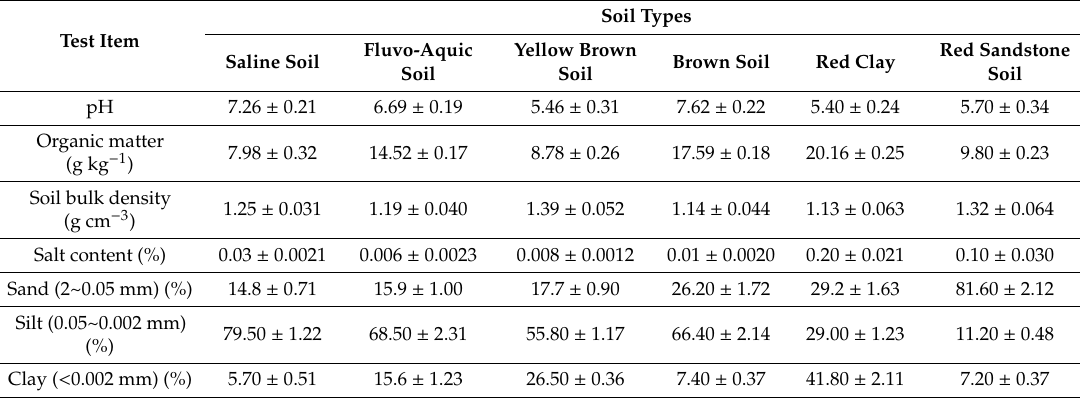
Figure 2. Geographic setting of the study area in China. Table 1. Basic physicochemical properties of the tested soils.